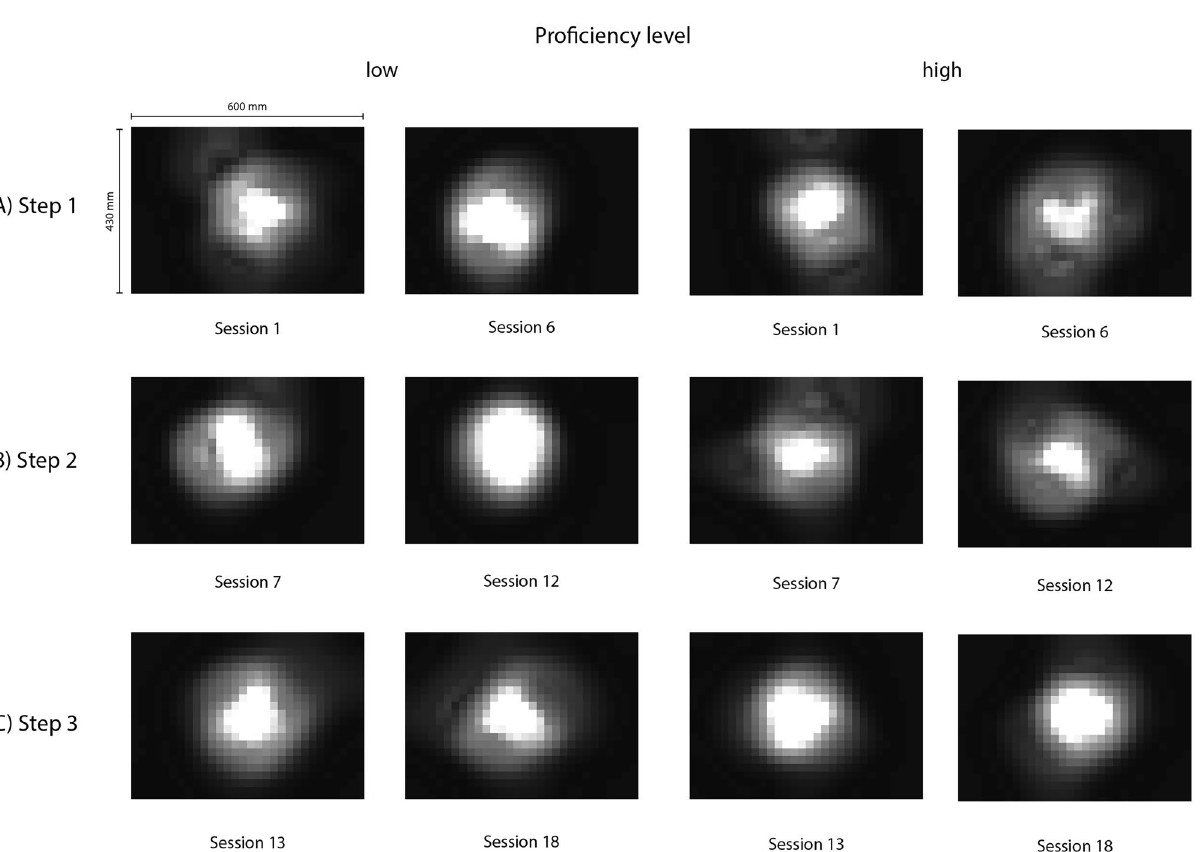
Figure 6. Grayscale heat maps for the first and last session of each step. Areas that have received more visual attention appear brighter. The term mm refers to